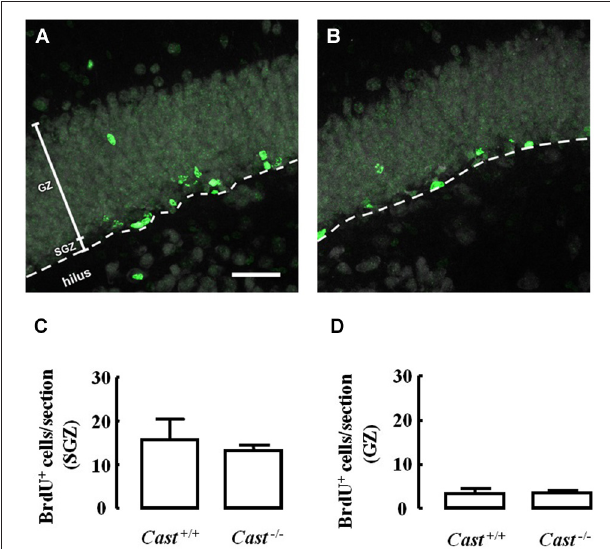
FIGURE 3 | Calpastatin deficiency does not alter the distribution of BrdU-positive cells in the DG . Representative images from hippocampal brain sections of Cast + / + (A) and Cast − / − (B) mice, showing BrdU-positive cells in green and nuclei, labeled with NeuN, in gray. Number of BrdU-positive cells in the SGZ (C) and the GZ (D) of the hippocampus. Scale bar: 40 µ m. Means ± SEM of 5 independent experiments. Two-tailed t -test, p > 0.05.